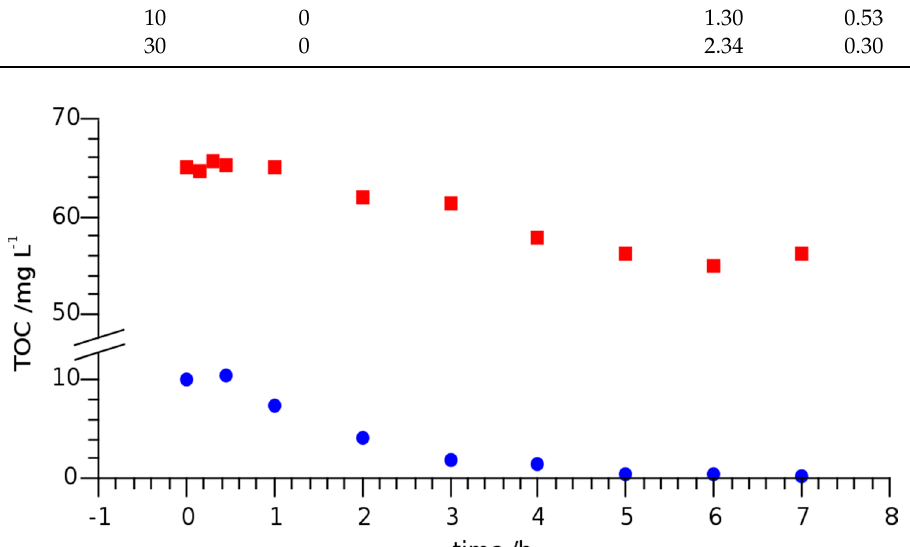
Figure 5. Total organic carbon (TOC) of LOM dissolved in MilliQ-water ( ● ) and river Erft water ( ■ ) at initial concentration of 20 mg L − 1 under UVC irradiation.